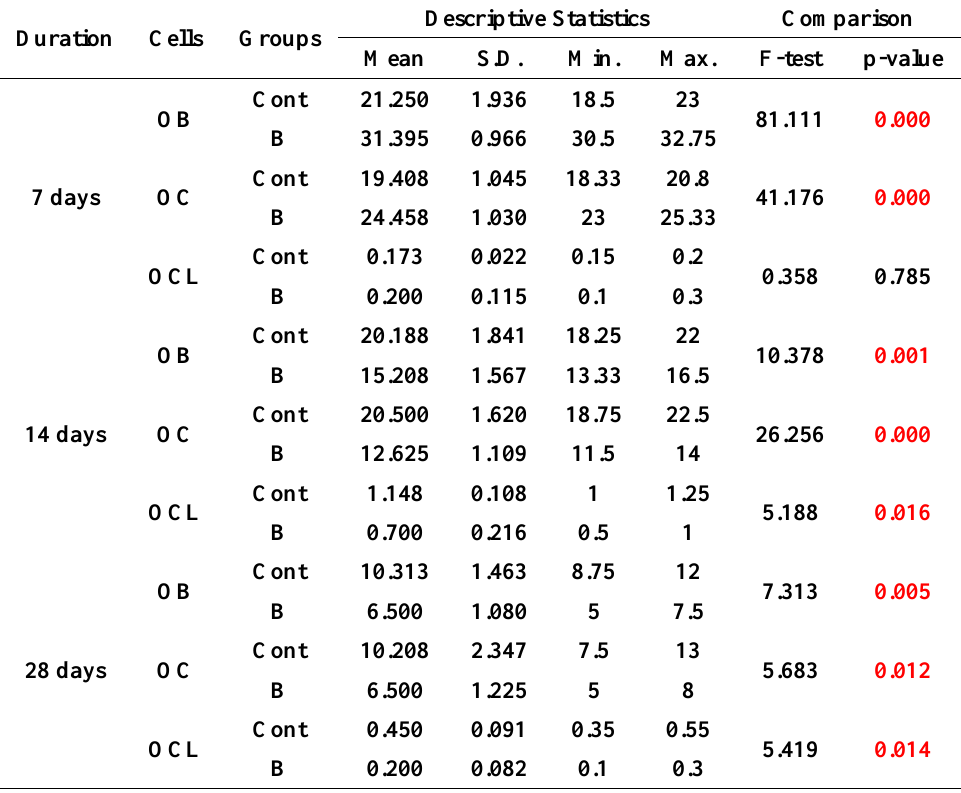
Figure (5) : Immunohistochemical view for bone Figure (6) : View after 28 days duration of bone sialoprotein group 14 days show positive sialoprotein with positive expression of expression to BSP in osteoblast (arrows) , osteocytes(arrow head),) and osteoblast (arrows). osteocyte (arrow head) and osteoclast (red DAB stain with counter stain hematoxylin arrow).Negative expression in bone trabeculae (BT). DAB stainX40 Table 2 : Descriptive statistics of the positive bone cells expressed by bone sialoprotein and groups’ difference in each duration.